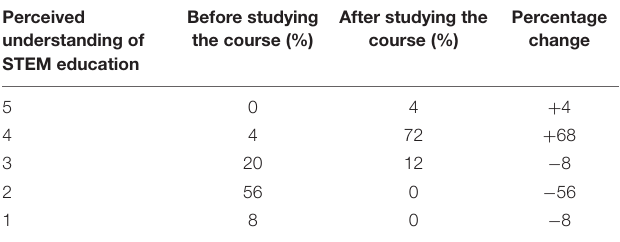
TABLE 1 | Understanding of STEM education before and after the course. Perceived understanding